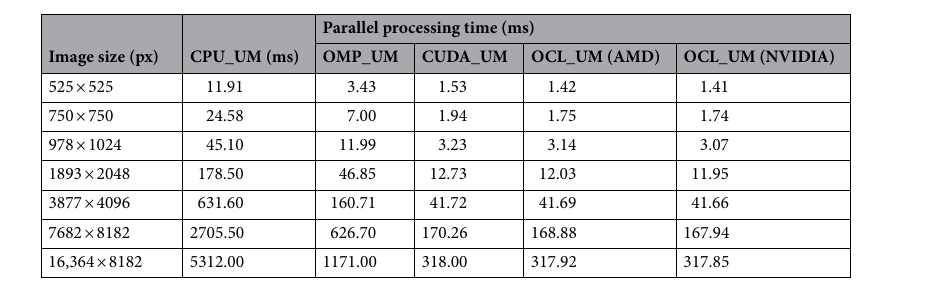
Table 4. Time-consuming comparison of UM